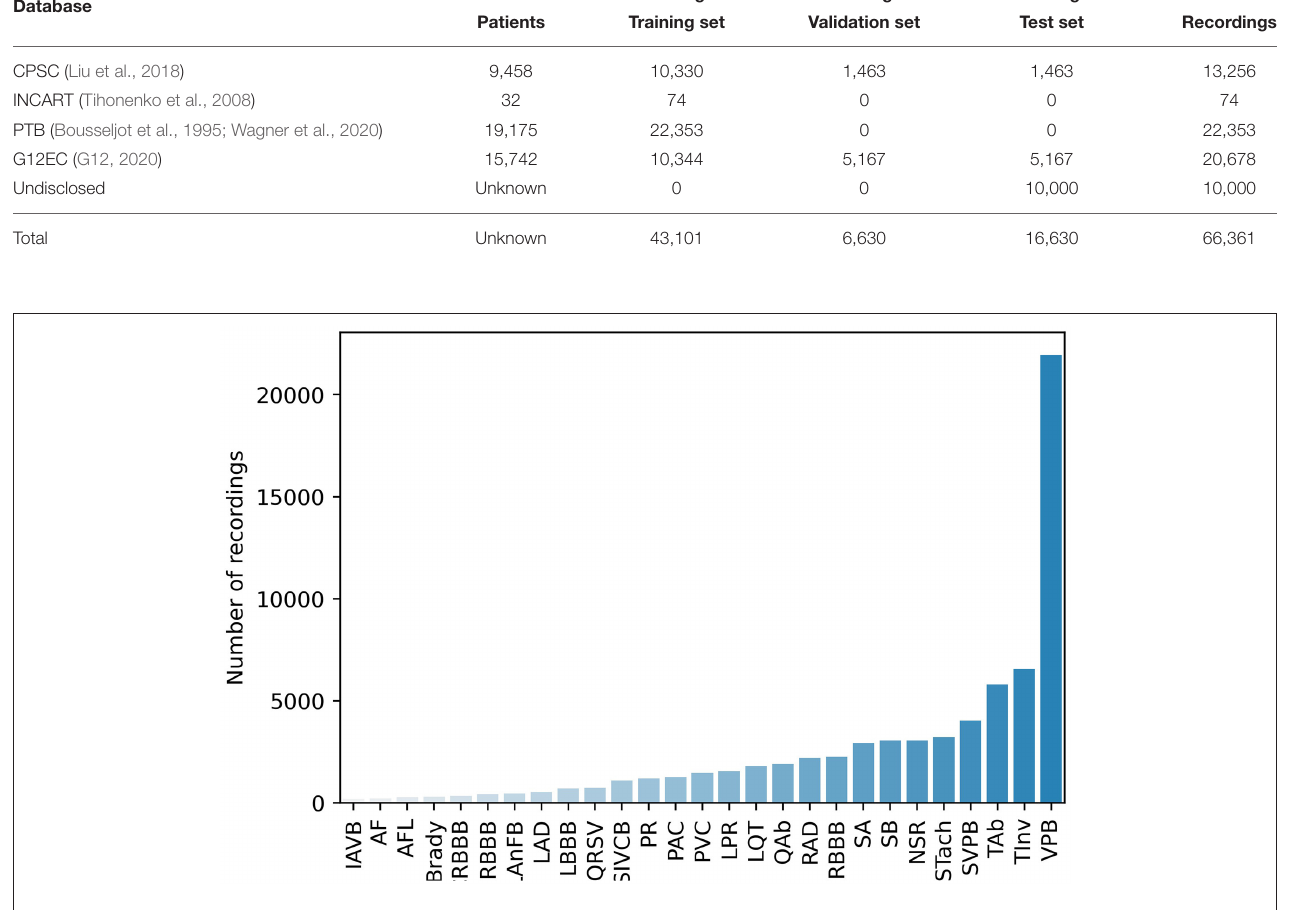
FIGURE 1 | Number of recordings of each scored